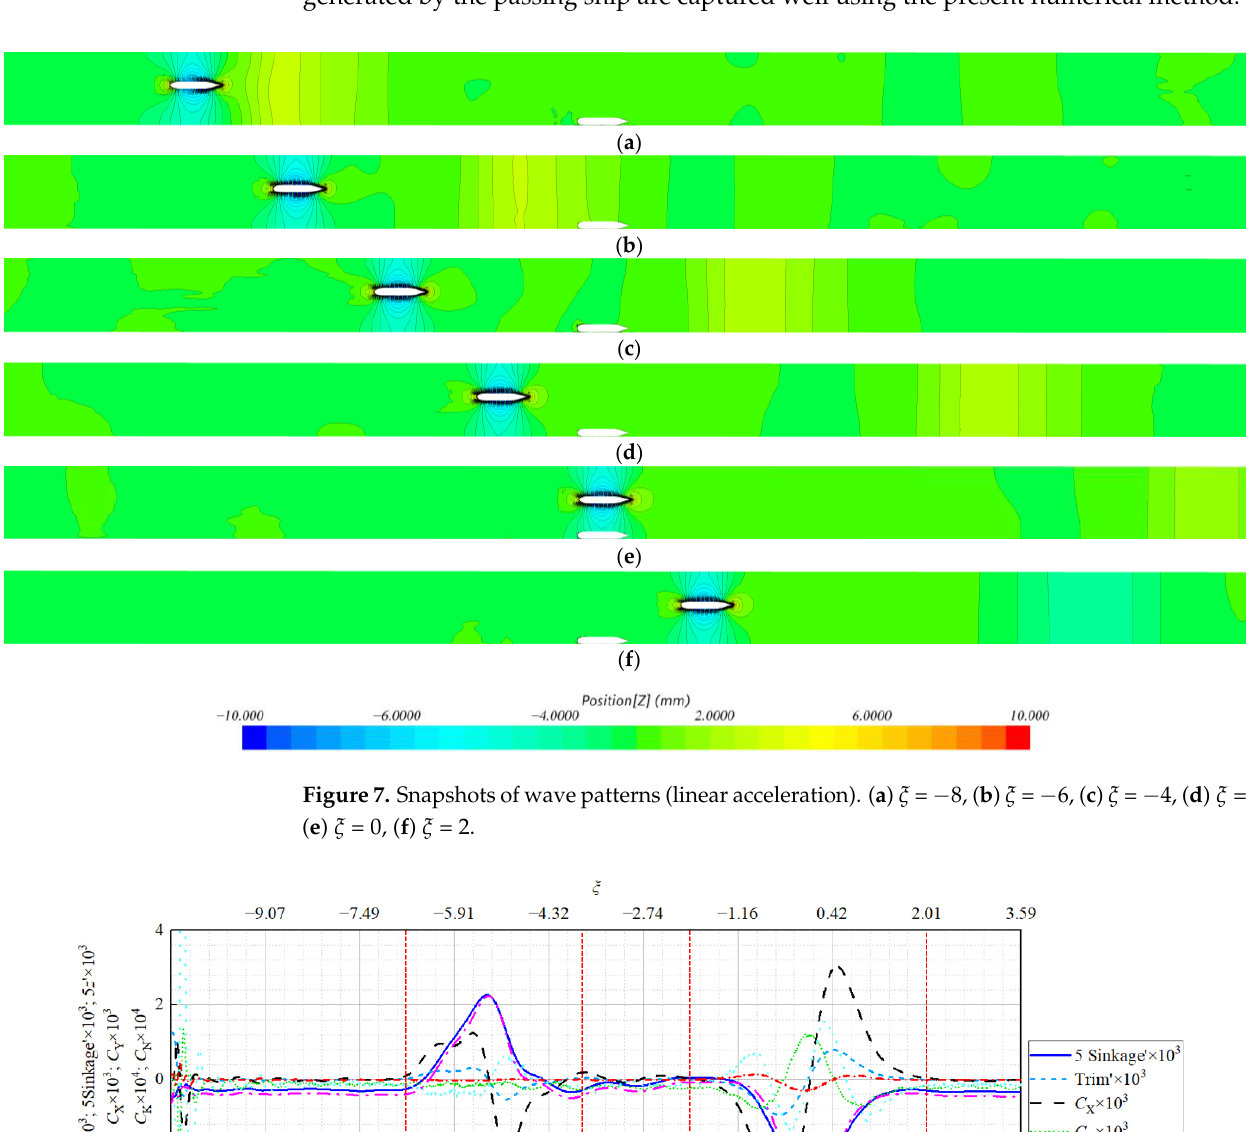
Figure 6. Time histories of passing speed in the numerical simulations.